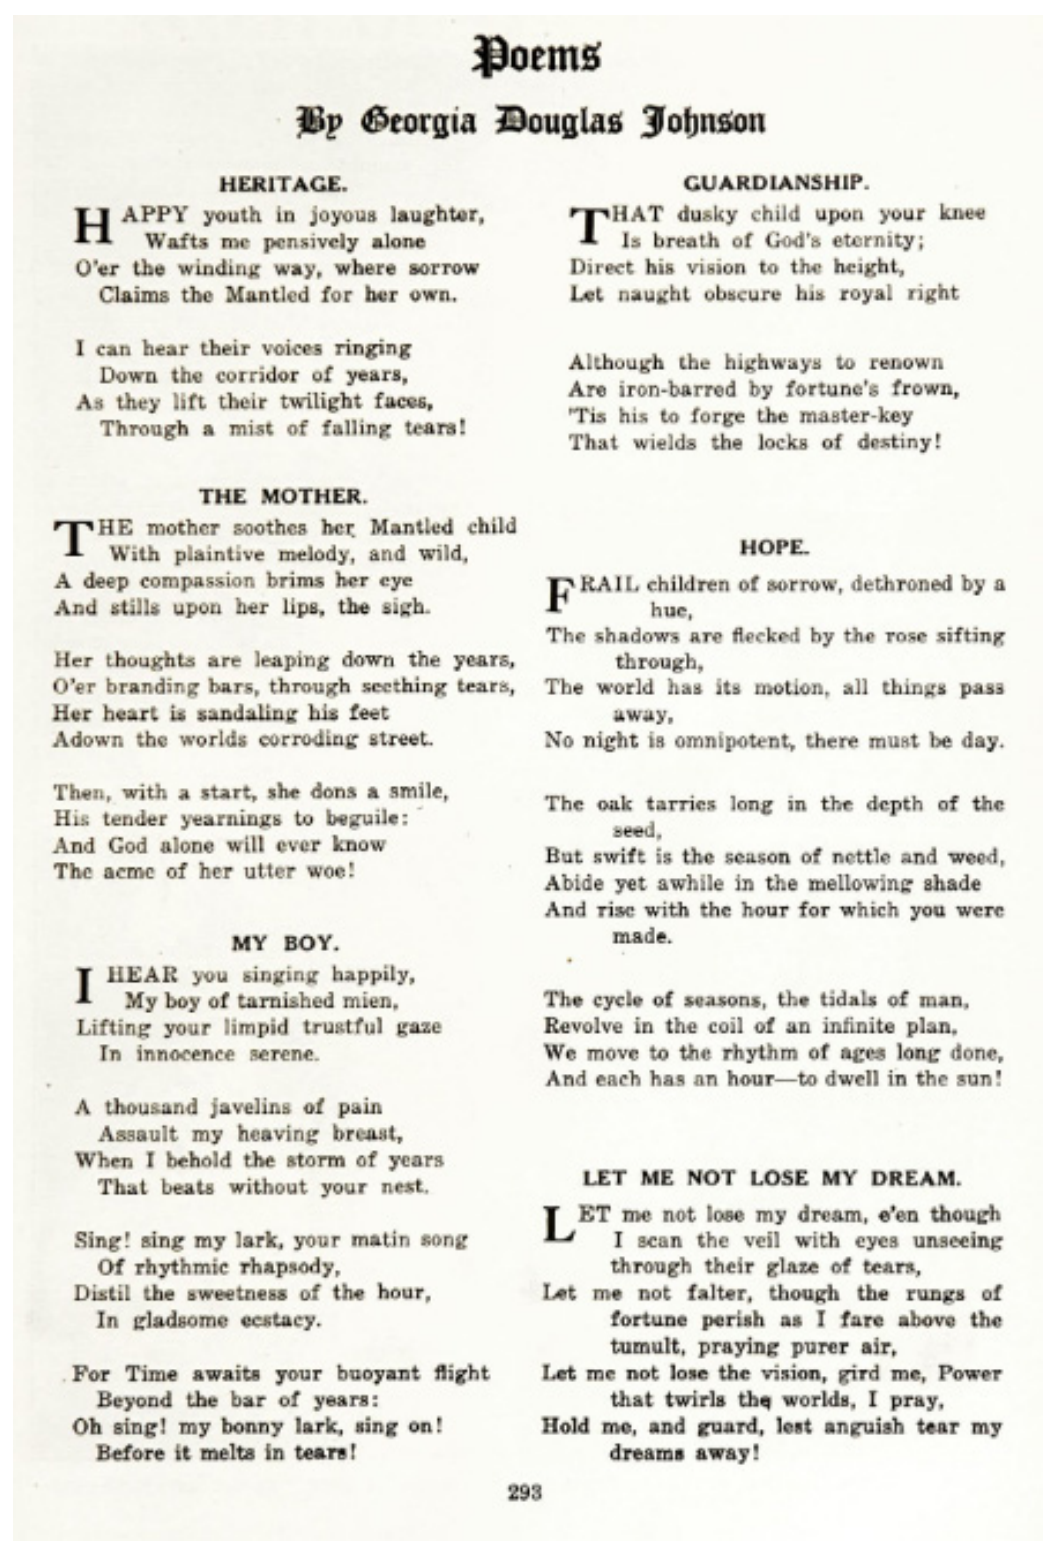
Figure 2. Georgia Douglas Johnson’s six poems featured in the 1917 edition of The Crisis ’s Children’s Numbers. ( The Crisis 1917, 14.6, p. 293), The Modernist Journals Project, https://modjourn.org/issue/bdr510854/, (accessed on 17 January 2022).